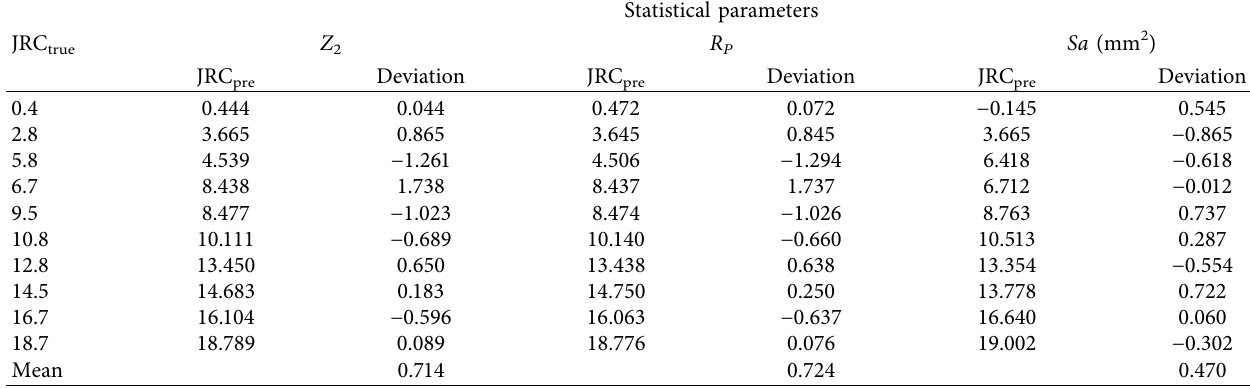
Table 3: Comparison of deviation between JRC